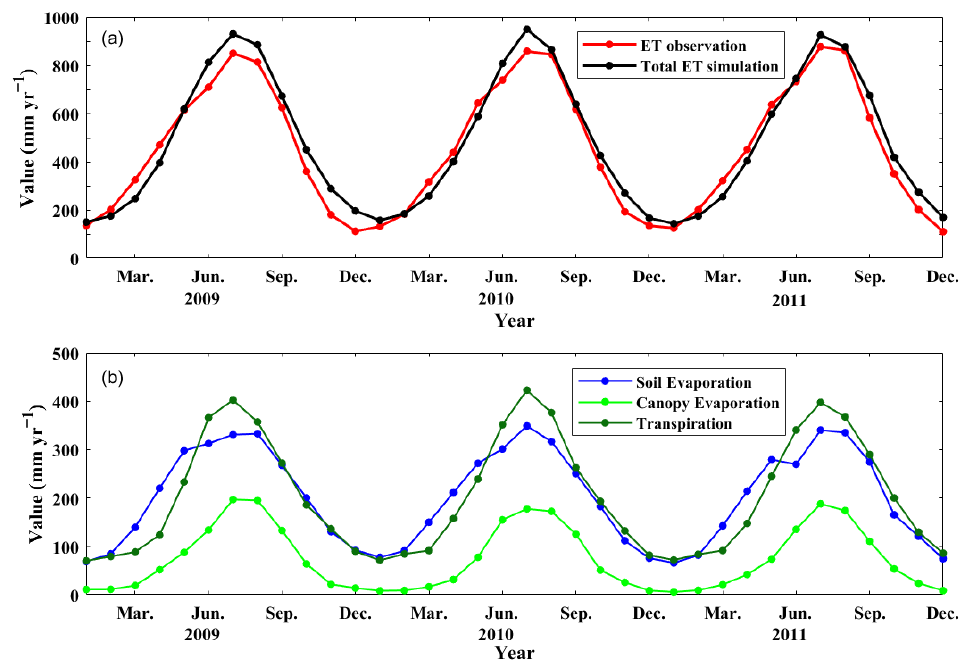
Figure 2. Monthly variation of the evapotranspiration (ET) observation and simulations from 2009 to 2011 in China: ( a ) total evapotranspiration observation and simulation; and ( b ) simulations of evapotranspiration’s three components, including soil evaporation, canopy evaporation, and transpiration.